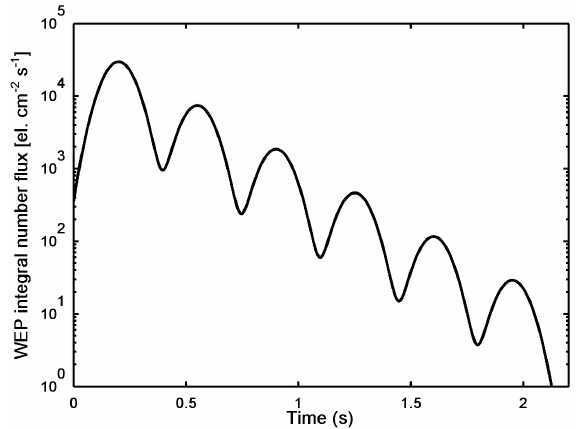
Fig. 7. Time dependence of the WEP electron flux used to simulate the decreasing train of precipitation pulses caused by the backscat- tering of precipitating electrons.